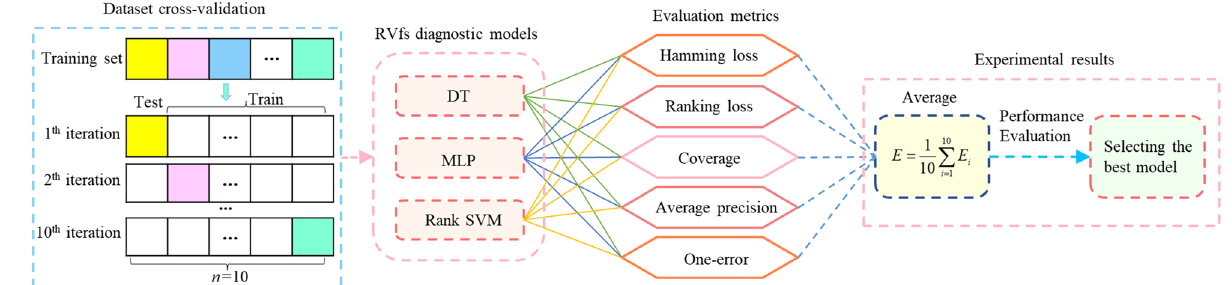
Figure 3. The experimental study process for RVMFL